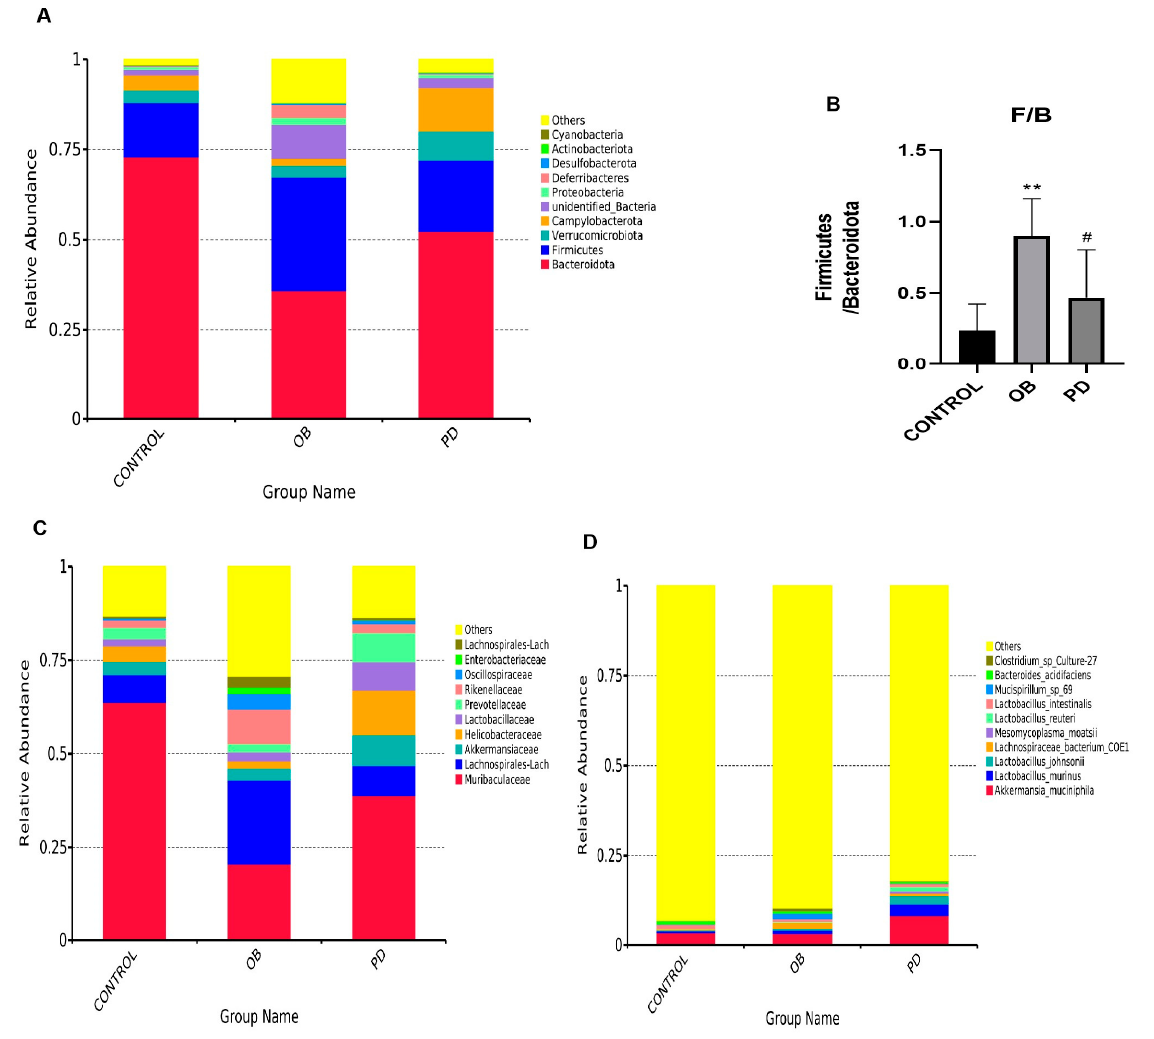
Figure 4. PD regulated the gut microbiota of ob/ob mice at the phylum, family and species levels ( A ) The relative abundance of the 10 top-ranked phyla were presented; ( B ) The ratio of Firmicutes/Bacteroidetes; ( C , D ) The relative abundance of the 10 top-ranked families and species were presented. ** p < 0.01, compared with the CONTROL group. # p < 0.05, compared with the OB group. n = 5.